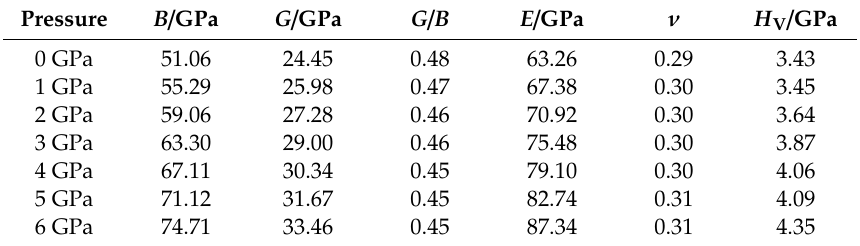
Table 4. Elasticity, modulus, Poisson’s ratio and hardness of Mg 23 Al 30 under di ff erent